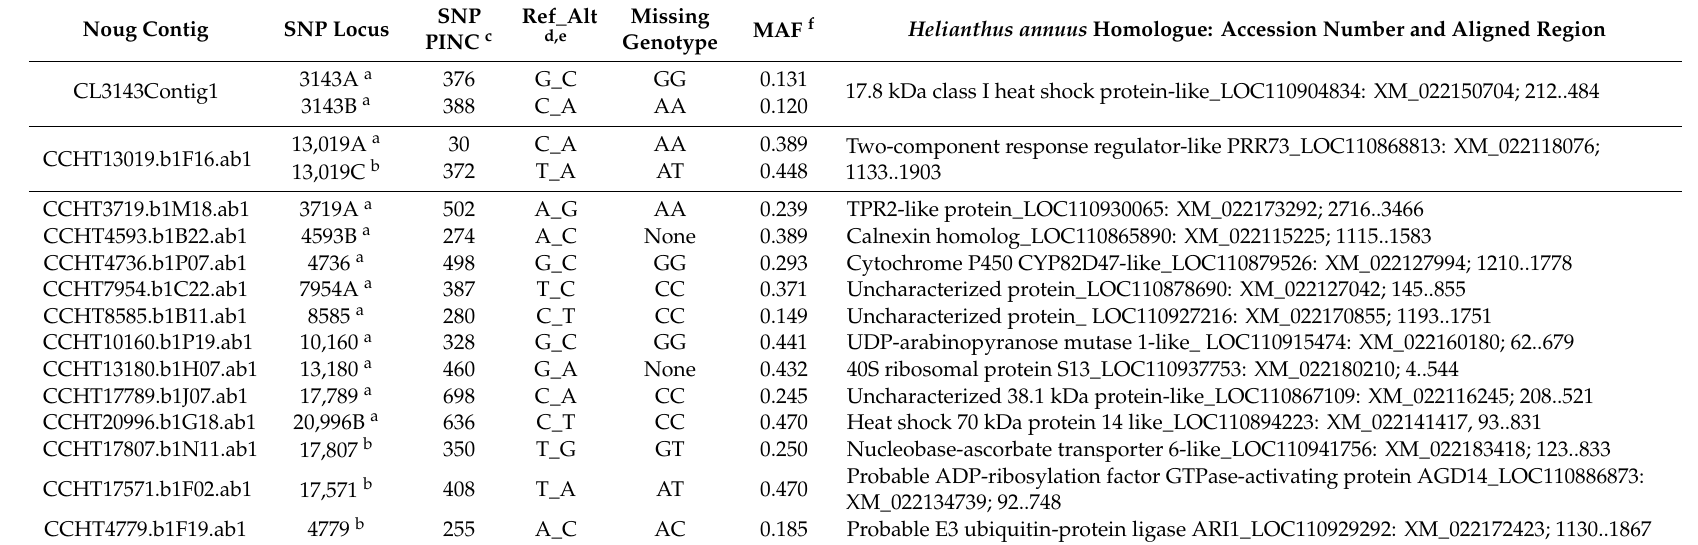
Table 1. Description of polymorphic single nucleotide polymorphic (SNP) loci that showed highly significant deviation from Hardy-Weinberg Equilibrium (HWE), and corresponding sunflower ( Helianthus annuus ) homologs of noug genes harboring the SNPs. Noug